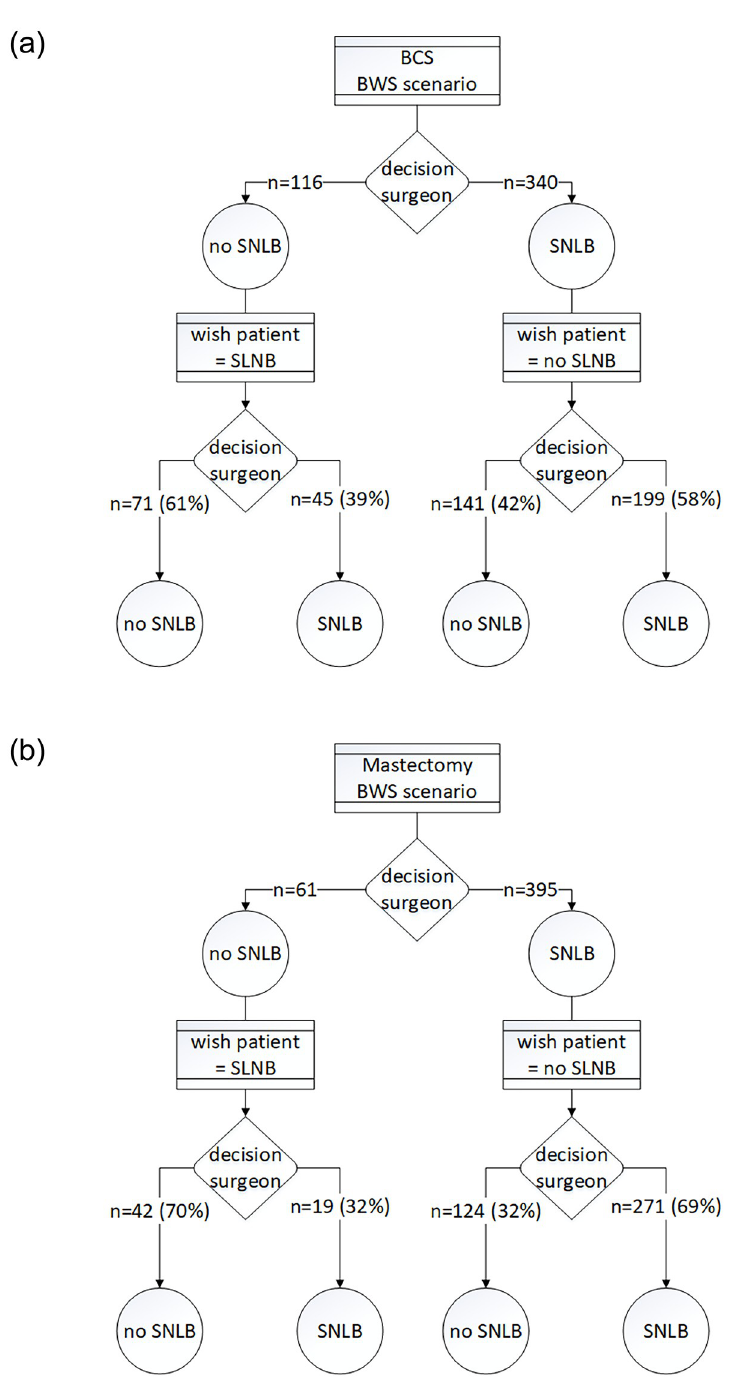
Fig 1. Influence of the patient’s wish on the decision to perform SLNB; 1a: for breast conserving surgery. 1b: for mastectomy.